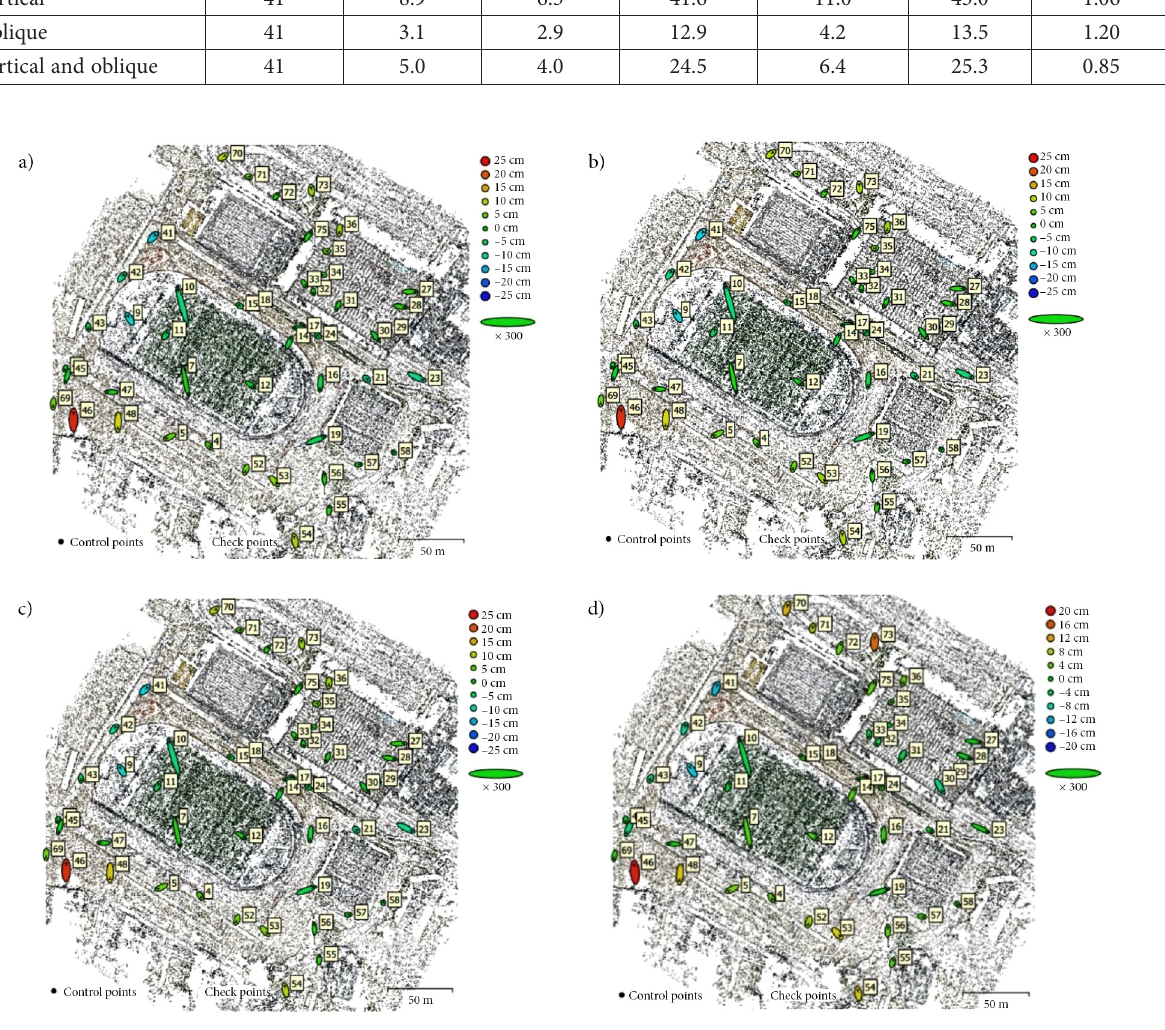
Figure 8. Visualization of the error distribution after aligning the control image block using the obtained elements of internal orientation as exact approximations: a – from almost vertical images; b – oblique; c – almost vertical and oblique; d – without exact IOE